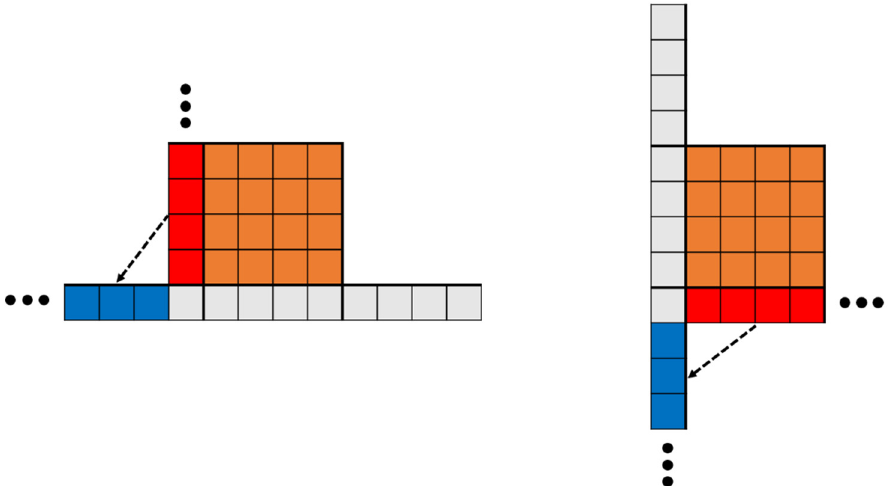
Figure 8. Extrapolation for the vertical directional modes ( left ) and the horizontal directional modes ( right ) in the vertical reference set.